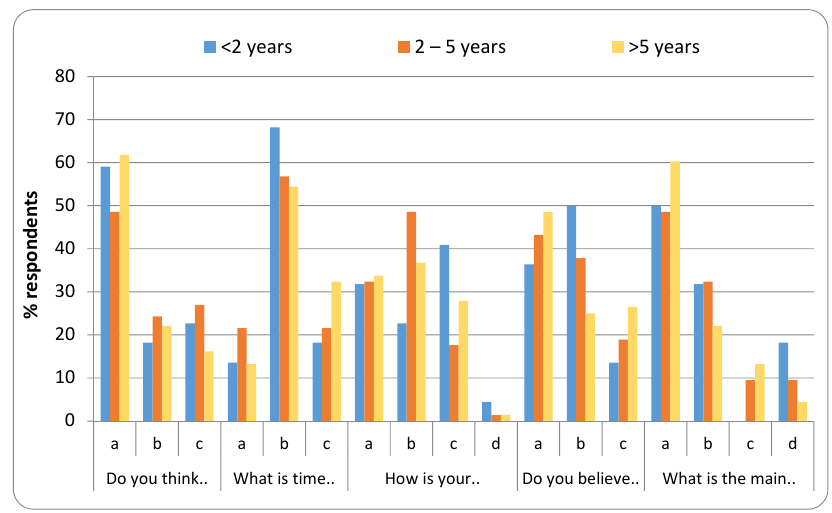
Figure 5. Distribution of responses related to practice according to educational status.